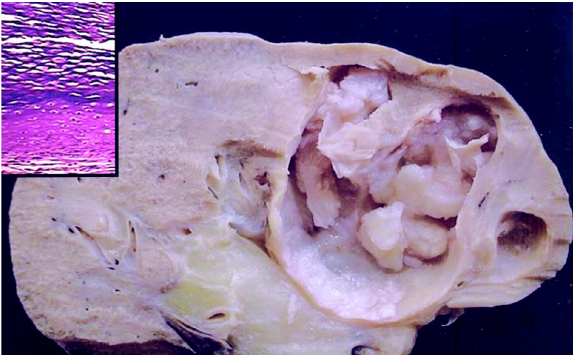
Figure 2 – Surgical specimen from nephrectomy presenting cyst with semi-solid content located in renal pelvis and adja- cent calices. Insert: histological study of the cyst wall, where we can observe lining epithelium (keratinized squamous epi- thelium). HE,